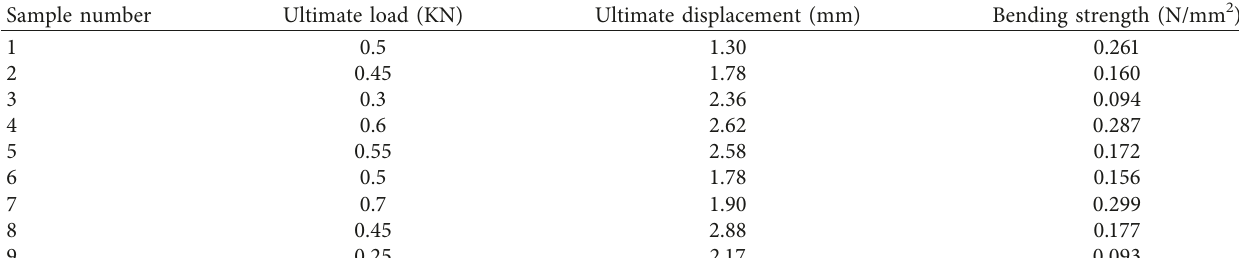
Table 7: Three-point bending ultimate loads and displacements of samples.